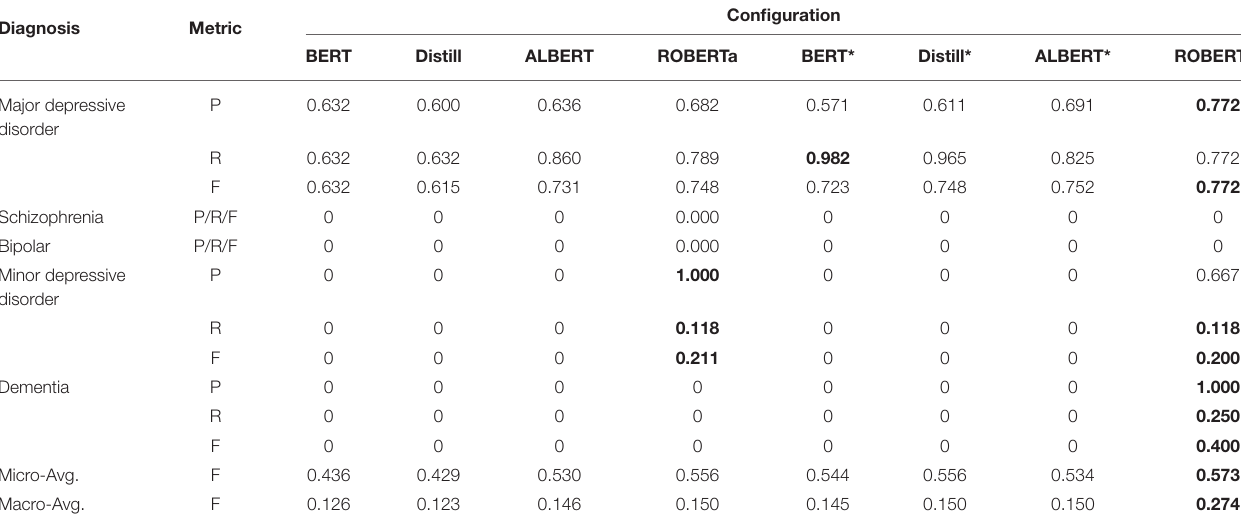
TABLE 2 | The performance of the BERT-based models with feature dependency on the test